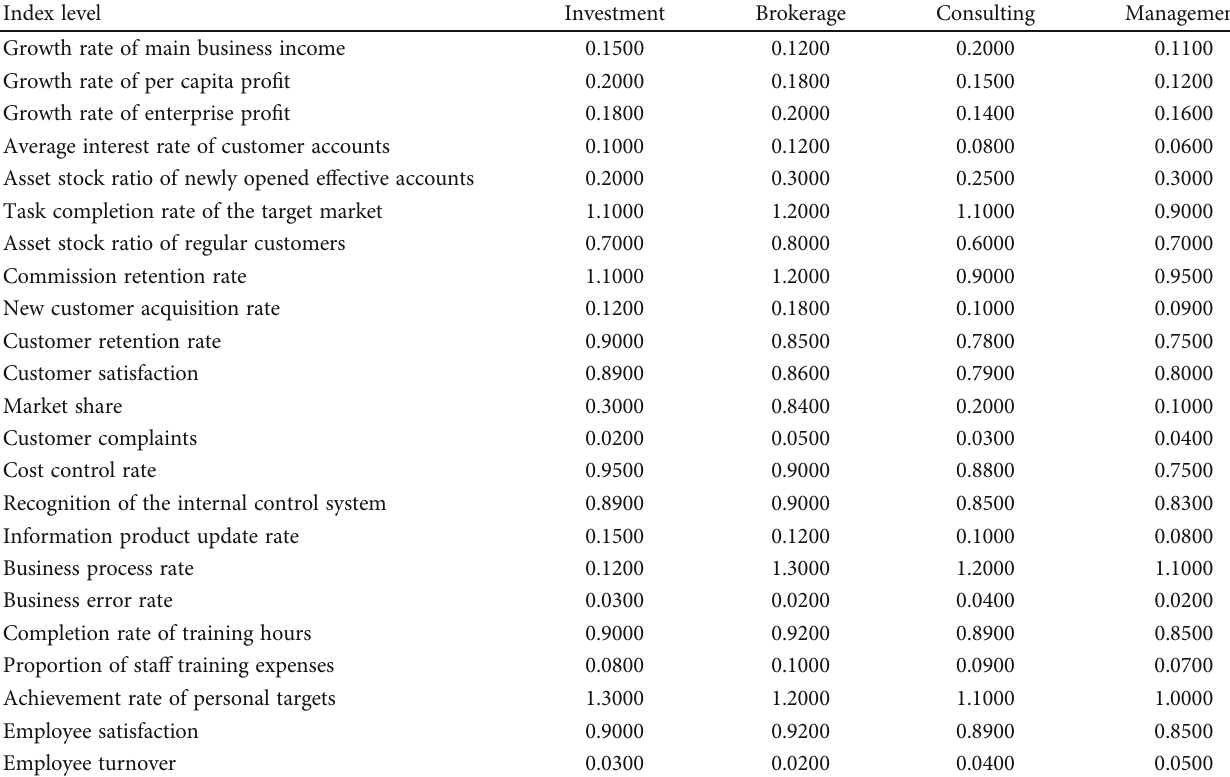
Table 2: Survey data of BSC-based performance evaluation index system for securities